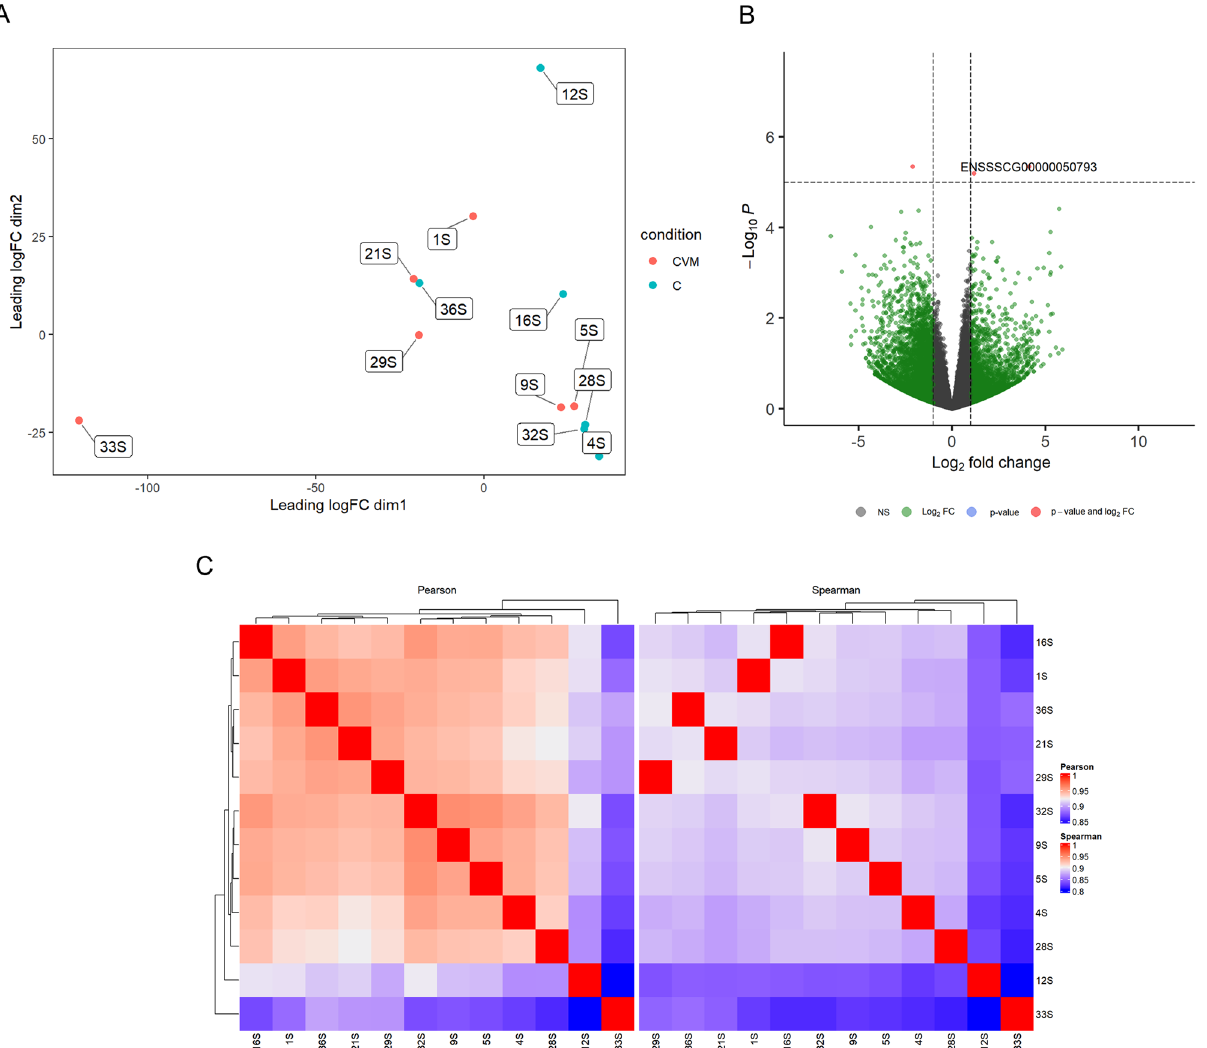
Figure 4. ( A ) Multi-dimensional scaling (MDS) plot showing the relation between Control and CV + M diet samples. ( B ) Volcano plot showing the relationship between FC and evidence of differential expression (-log FDR) for Control vs CV + M. ( C ) Clustering of sample to sample correlations—Control vs CV + M. Hierarchical clustering of treatment condition samples based on Pearson (left) and Spearman correlations